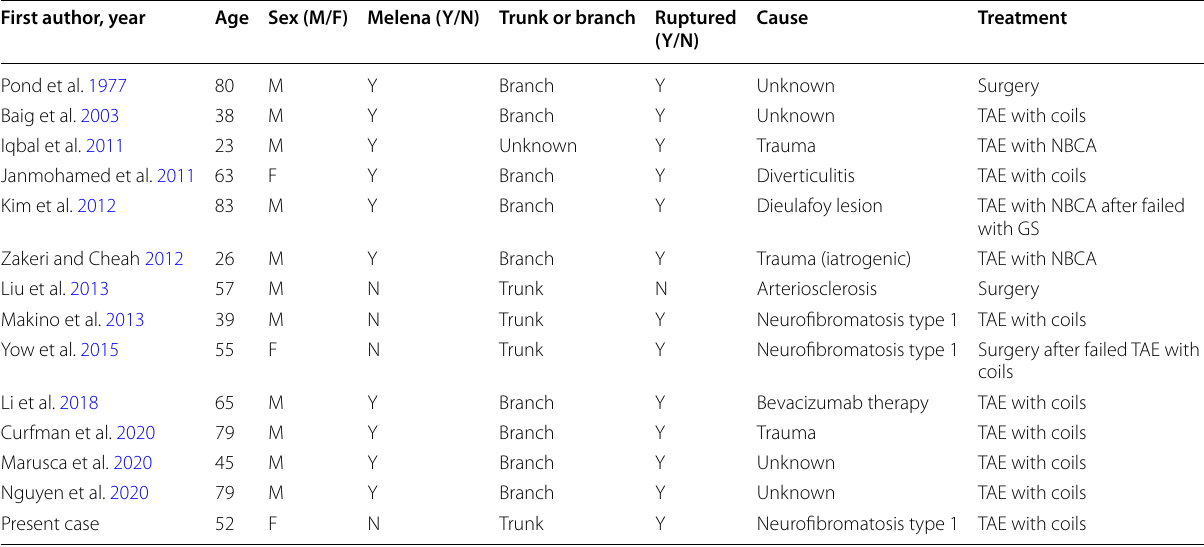
Table 1 Characteristics of the reported cases with superior rectal artery